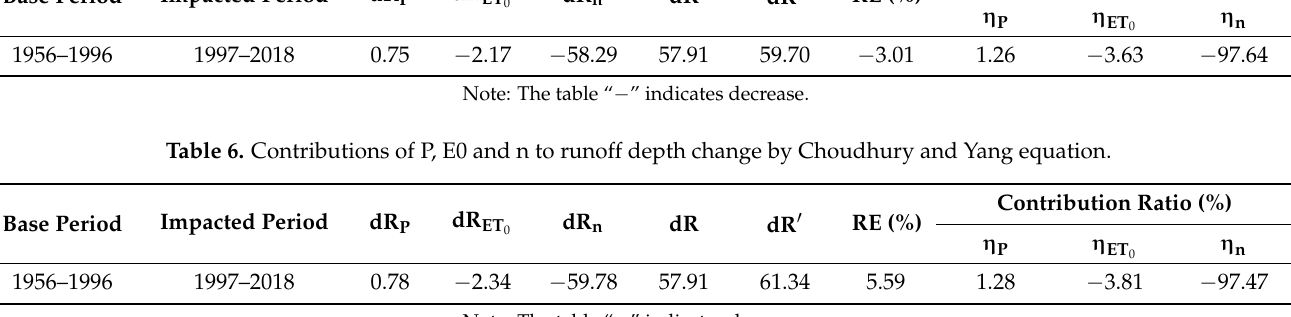
Table 5. Contributions of P, E0 and n to runoff depth change by Fu equation. Base Period